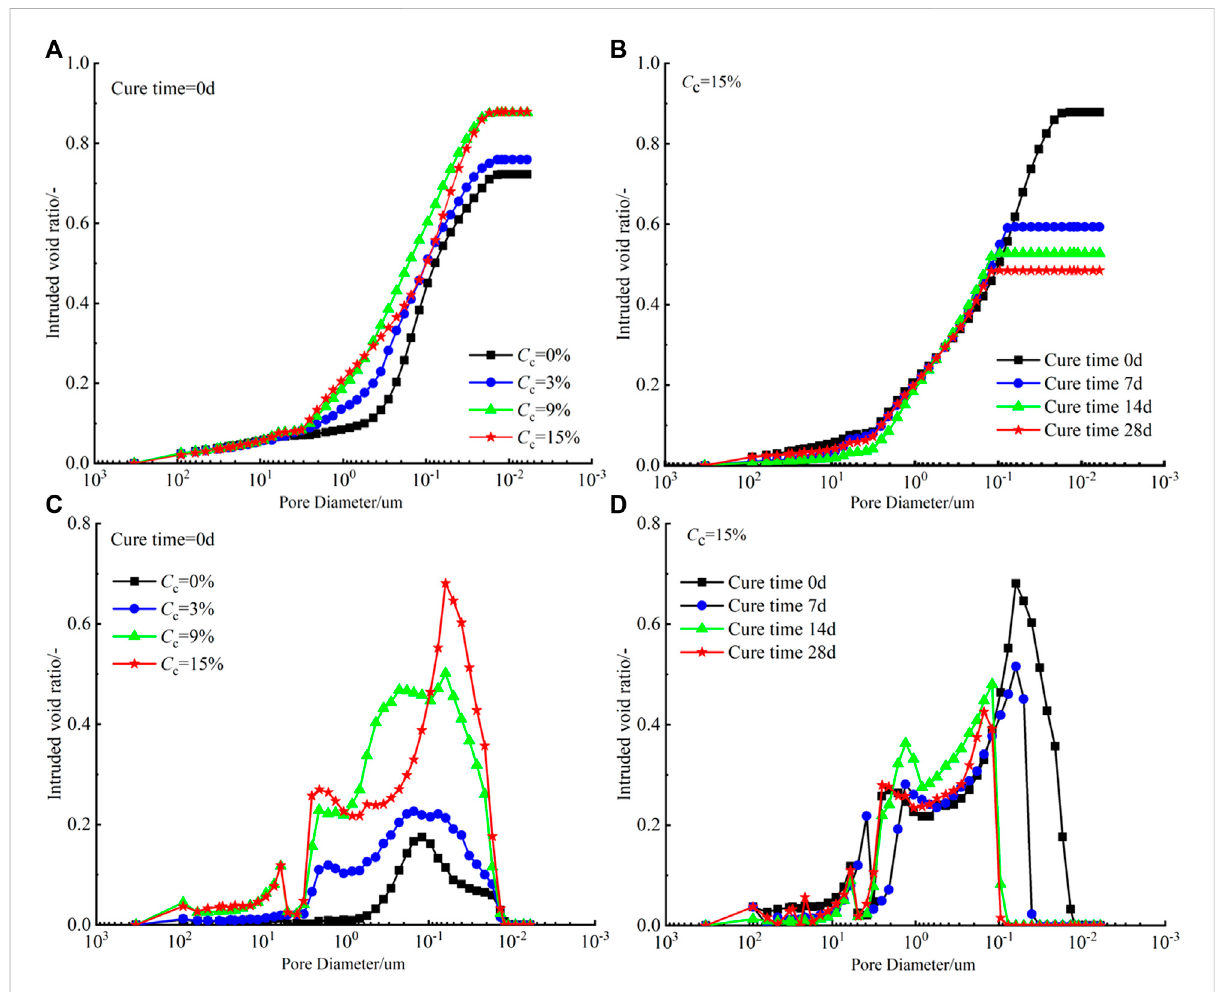
FIGURE 10 Cumulative and pore size distribution curves of cement modi fi ed diatomite.